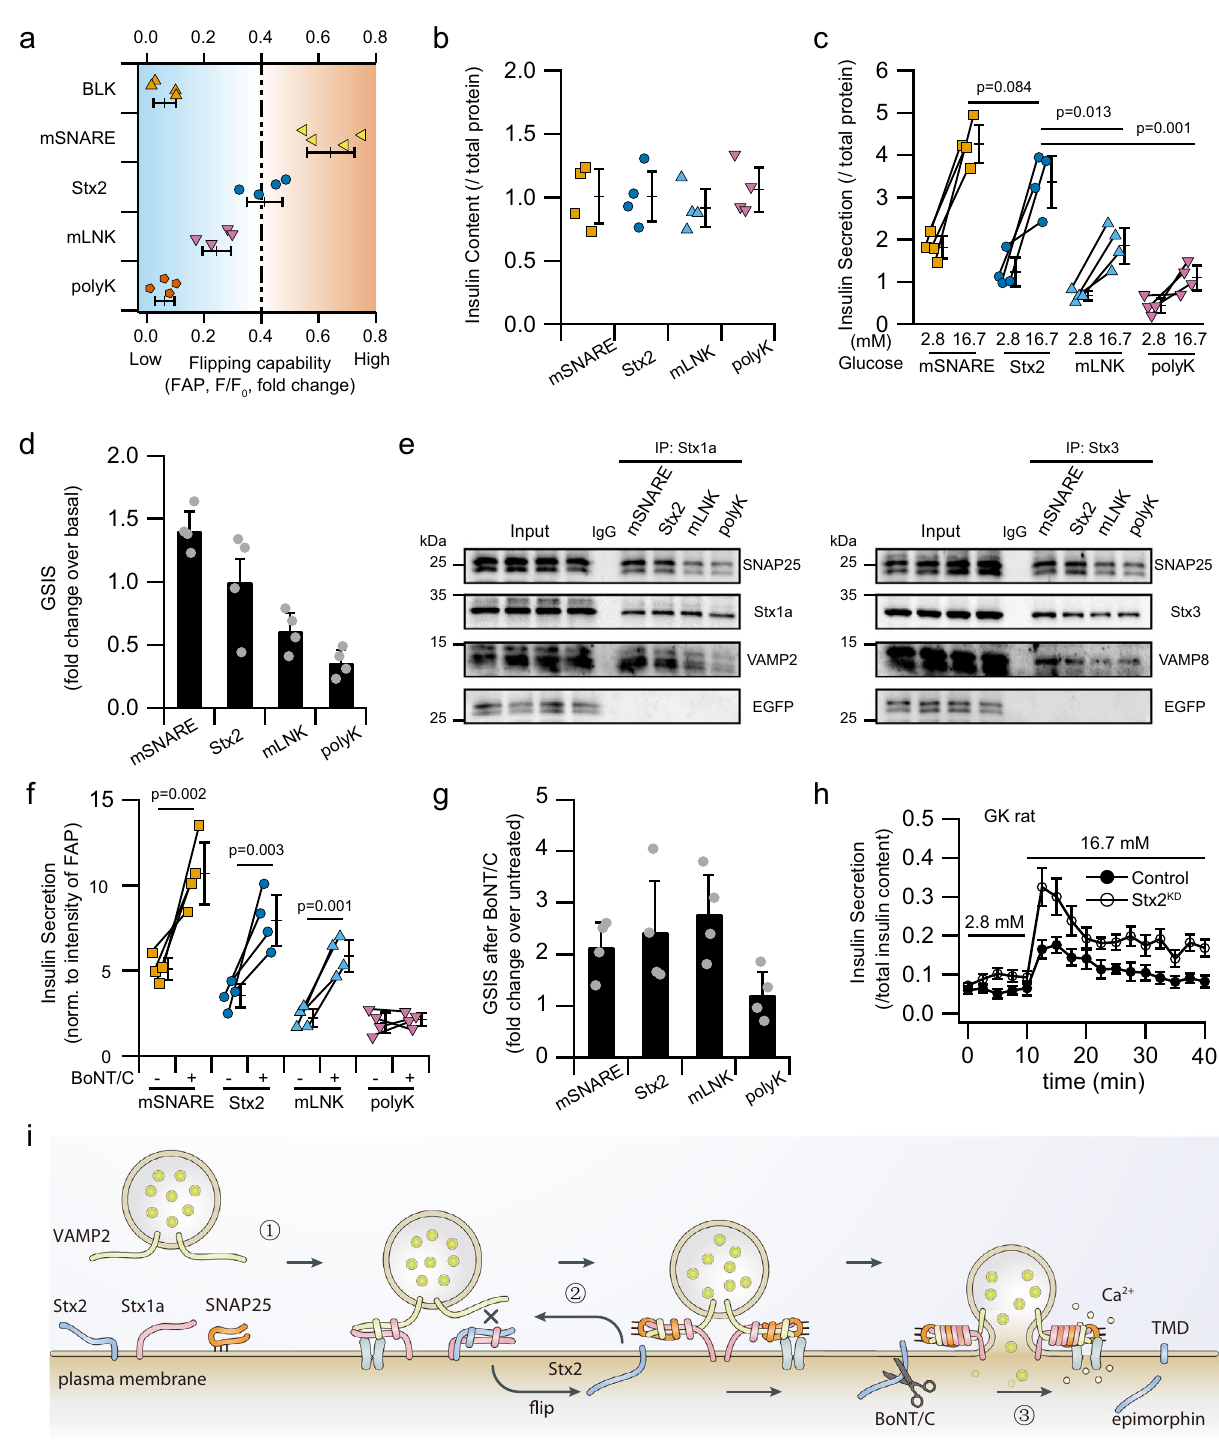
Syntaxin-2 depletion can restore the de fi cient GSIS in SNARE- de fi cient T2D